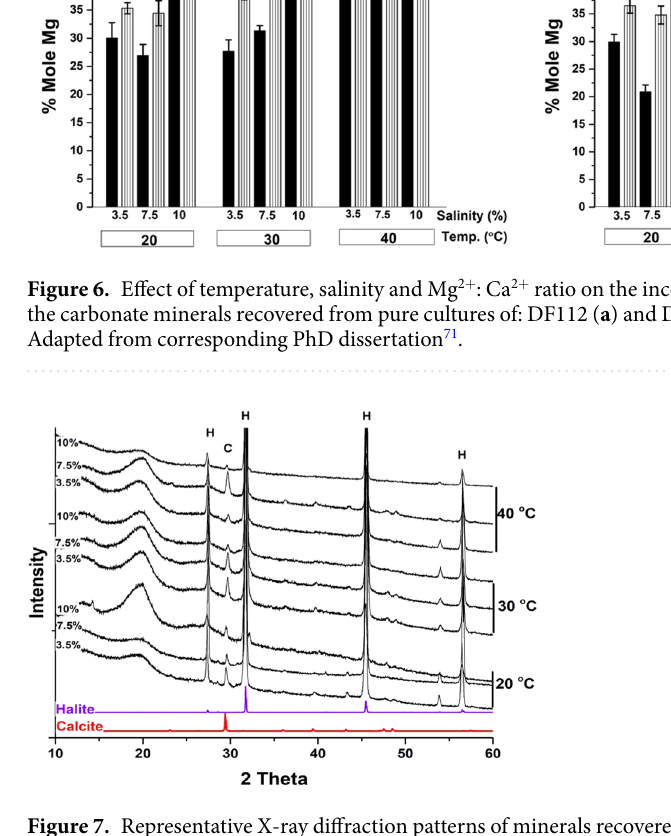
Figure 7. Representative X-ray diffraction patterns of minerals recovered from DF112 and 2141 cultures using media with different salinities and temperatures and a Mg 2 + : Ca 2 + ratio of 1. Included for comparison are the XRD patterns of calcite and halite standards. C: calcite, H: halite. Modified from corresponding PhD Dissertation 71